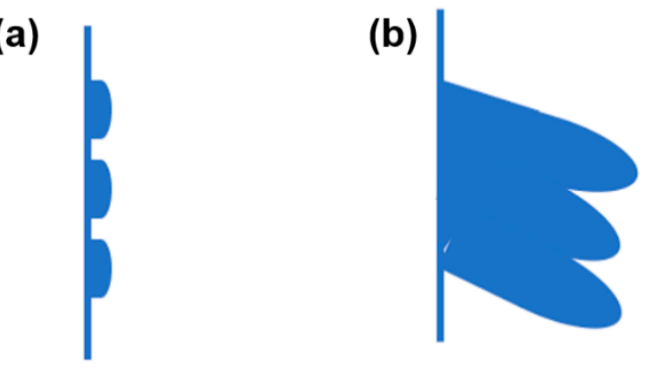
Figure 6. 3D morphology of primary Widmanstätten sideplates from different perspectives. ( a ) X–Y, ( b ) X–Z, ( c ) Y–Z.